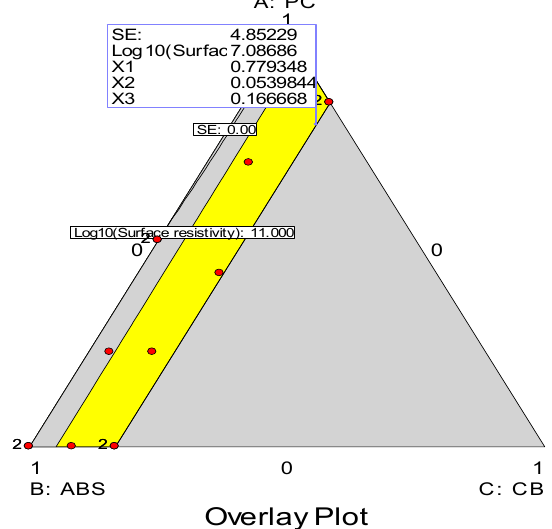
Figure 12. Overlay mapping @ 900 MHz with carbon black masterbatch.